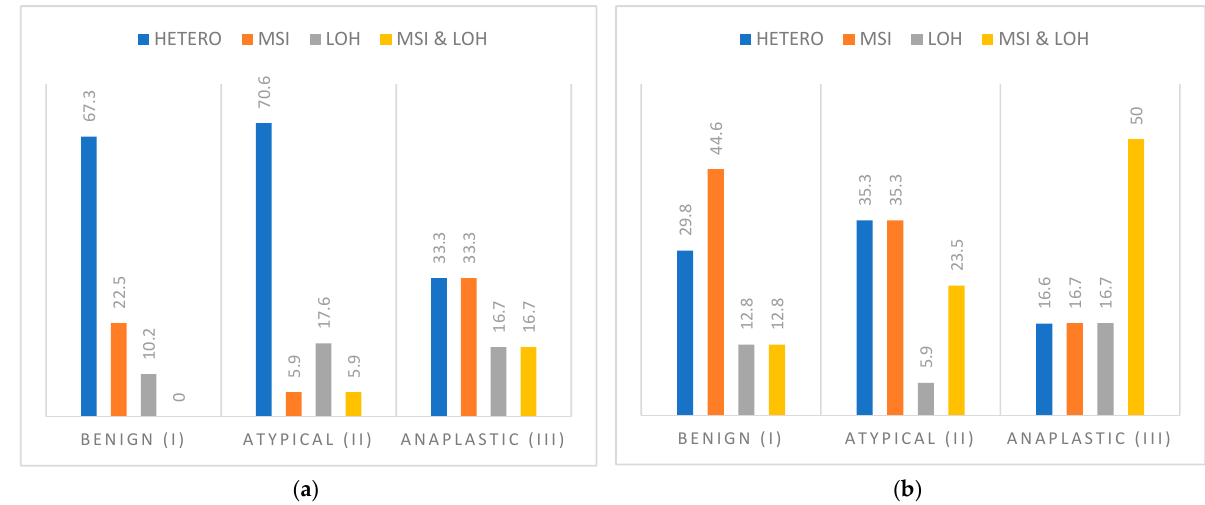
Figure 1. ( a ) The results (in percentages) of the pooled analysis of two microsatellite markers D16S752 and D16S3025 for the CDH1 gene in different grades of meningioma. Legend: HETERO—a heterozygote that has no genetic change; MSI—microsatellite instability; LOH—loss of heterozygosity. ( b ) Results (in percentages) of the pooled analysis of two microsatellite markers D16S752 and D16S3025 for the CDH2 gene in different grades of meningioma. Legend: HETERO—a heterozygote that has no genetic change; MSI—microsatellite instability; LOH—loss of heterozygosity.